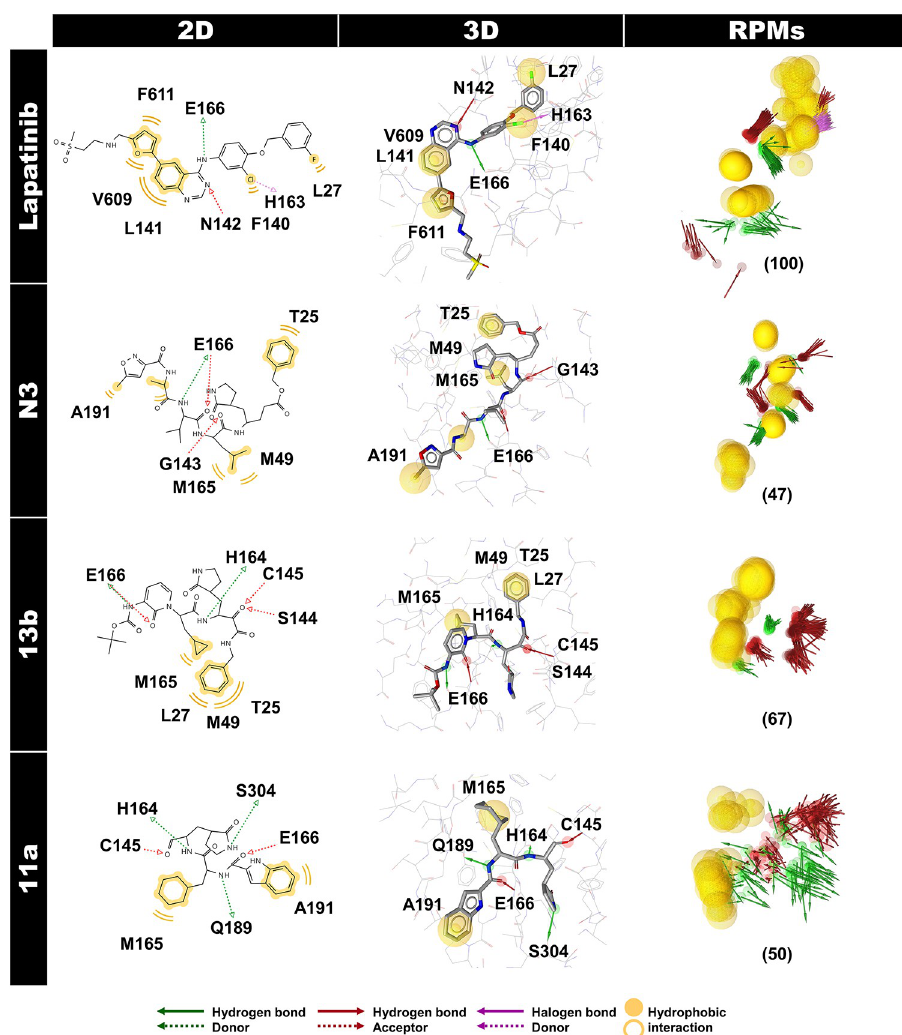
Fig 8. The pharmacophore models of lapatinib and peptidomimetic inhibitor(s) in complex with SAR-CoV-2 3CL pro . The 2D and 3D pharmacophore models of the first representative frame of lapatinib at 401 ns, and peptidomimetic inhibitors N3, 13b, and 11a at 81 ns, where RPMs derived from MD trajectories of lapatinib-3CL pro complex (401–500 ns), and peptidomimetic inhibitor(s)-3CL pro complex (81–100 ns) are illustrated on the right column. The green arrow, red arrow, purple arrow, and yellow color sphere (or circle in 2D) are pharmacophore features of hydrogen bond donor (HBD) and acceptor (HBA), halogen bond donor (XBD), and hydrophobic interaction properties,